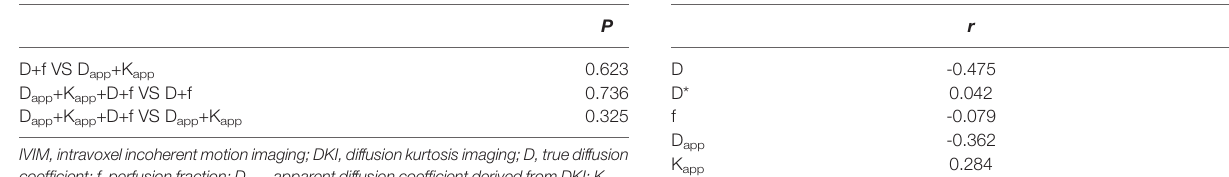
TABLE 6 | Comparison of the diagnostic performance between IVIM and DKI for differential diagnosis by DeLong test.